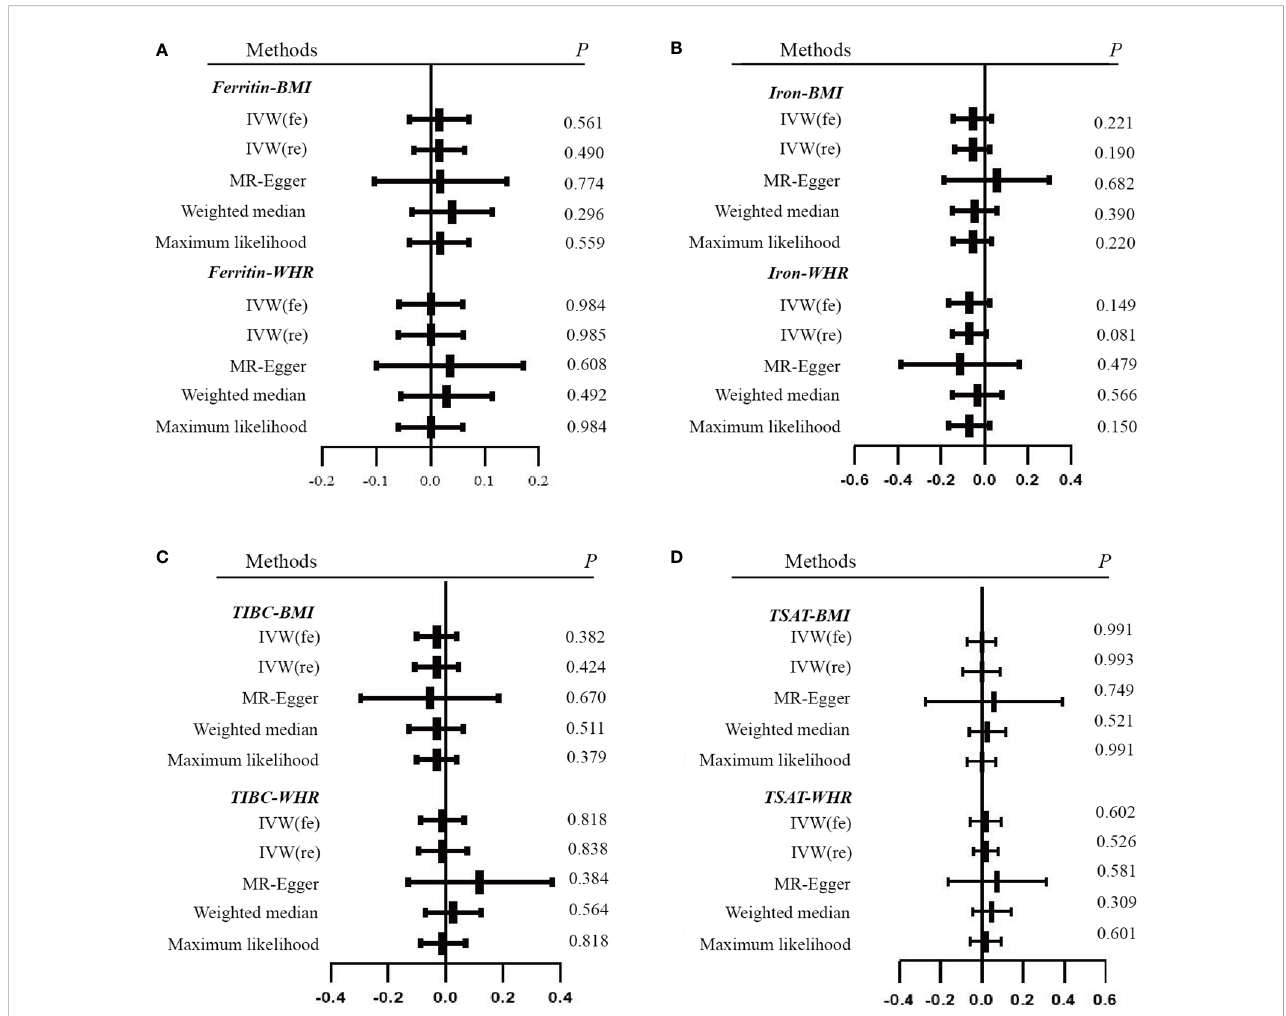
FIGURE 2 Forest plots of Mendelian randomization analyses of the association between genetically predicted iron status and obesity-related traits. (A) serum ferritin – BMI and WHR; (B) serum iron – BMI and WHR; (C) TIBC – BMI and WHR; (D) TSAT - BMI and WHR. Data are expressed as raw b with 95% CI. IVW, inverse variance – weighted method; fe, fi xed effects model; re, multiplicative random effects model; BMI, body mass index; WHR, waist-hip ratio; TIBC, total iron-binding capacity; TSAT, transferrin